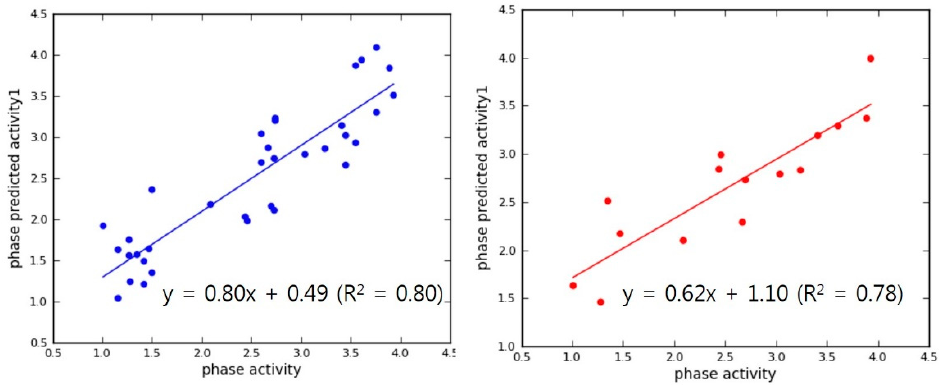
Figure 4. Representative 3D-QSAR models: APRRR215 (upper) and AHPRRR104 (lower).